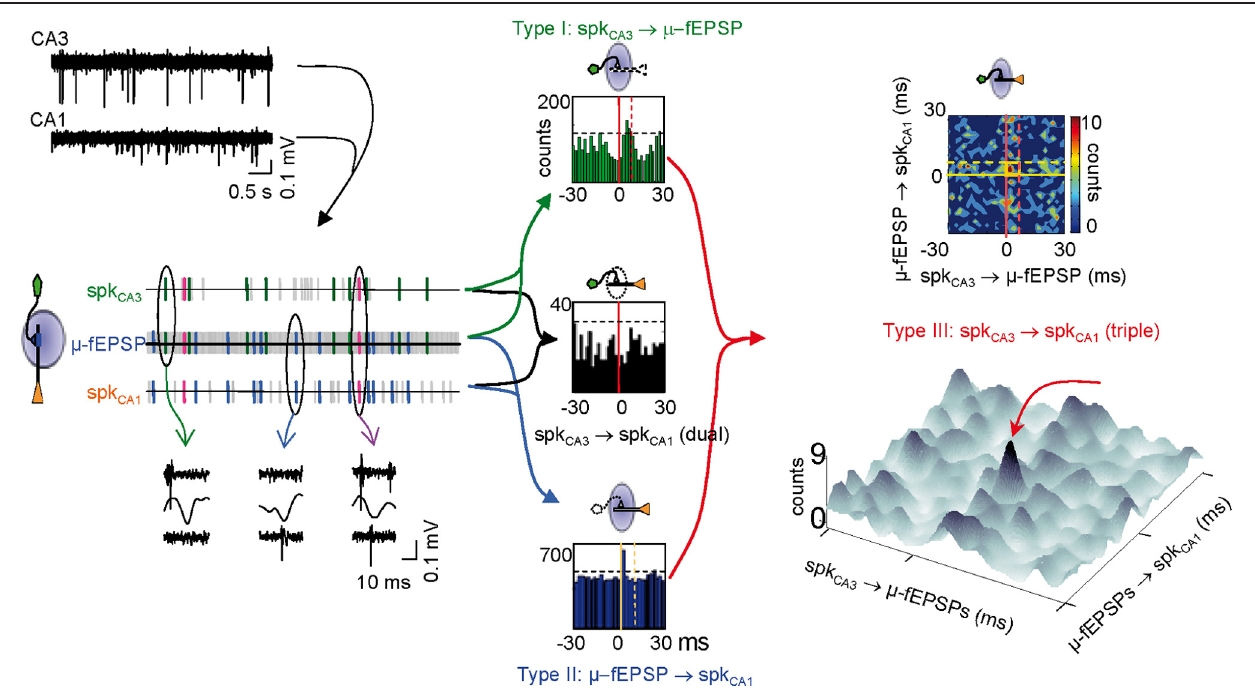
FIGURE 5 | Identification of monosynaptically connected cell pairs in the CA3-CA1 network. Using the excitatory quanta composing the baseline activity of Schaffer-LFPs ( μ -fEPSPs) allows discriminating synaptically connected CA3 and CA1 units. The upper left traces correspond to filtered simultaneous multiunit recordings in the stratum pyramidale of the CA3 and CA1 regions. Following spike sorting, spike trains of pairs of pre- and postsynaptic units were correlated with point processes of concurrent Schaffer μ -fEPSPs obtained from LFPs. Plausible monosynaptic coincidences are color coded as follows: Type I, green (in-cluster firings); Type II, blue (Schaffer spikes); Type III, magenta (Spike transfer efficiency). An example of raw data for each case is shown below (ovals). Horizontal dashed lines in dual histograms mark the significance level ( α = 0 . 05, Surrogate test). Counts contained within the periods delimited by vertical lines in dual cross-correlations of Type I (green histogram) and II (blue histogram) are candidates for monosynaptic